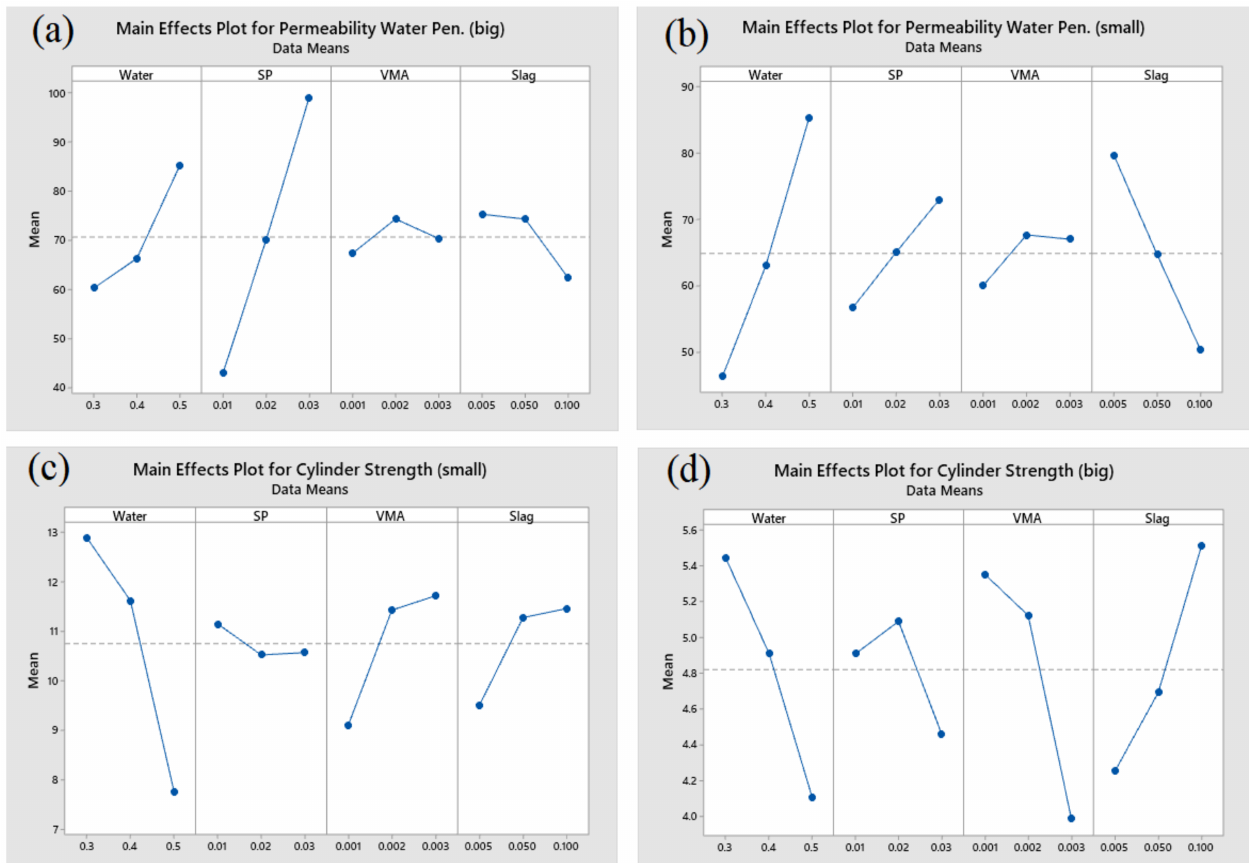
Figure 18. Main effect of plots for ( a ) permeability water penetration depth for coarse aggregate sample, ( b ) permeability water penetration depth for fine aggregate sample, ( c ) mass-cylinder strength with fine aggregate sample, and ( d ) mass- cylinder strength with coarse aggregate